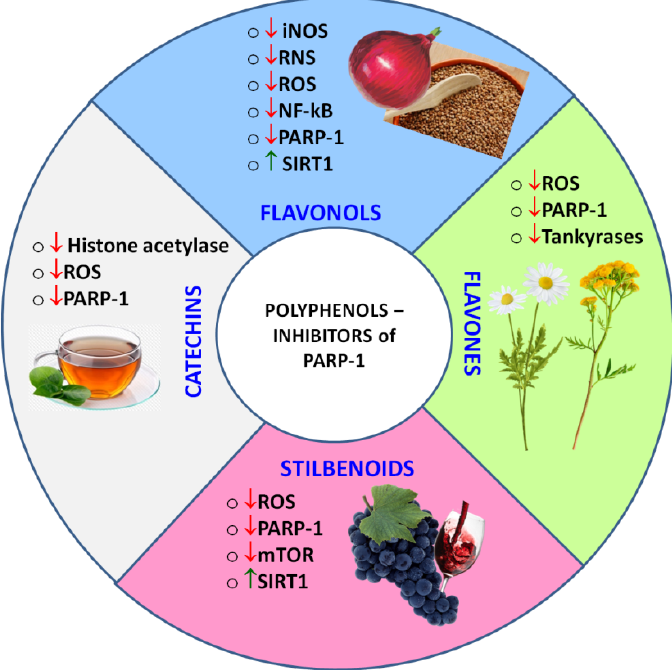
Figure 7. Classes of polyphenols, whose representatives were found to act as PARPi, and the observed polyphenol-induced regulatory effects. ↑ - up-regulated, ↓ - down-regulated.